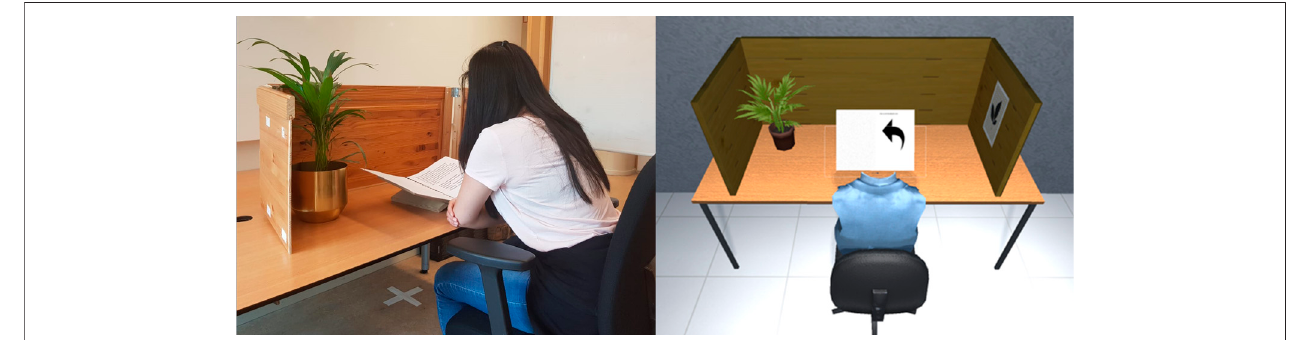
FIGURE 1 | Photograph of a participant in the real-world experimental setting (LEFT) and overview from an observer ’ s point-of-view of the virtual experimental environment created in Unity (RIGHT) .